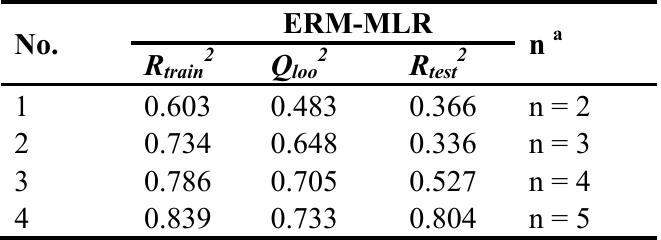
Table 2. The statistical parameters of obtained ERM-MLR